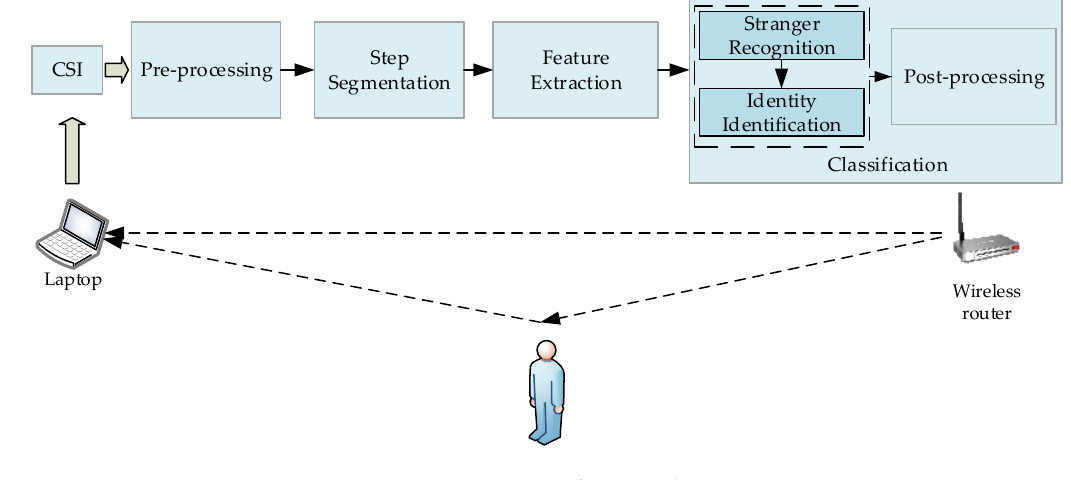
Figure 1. System framework.